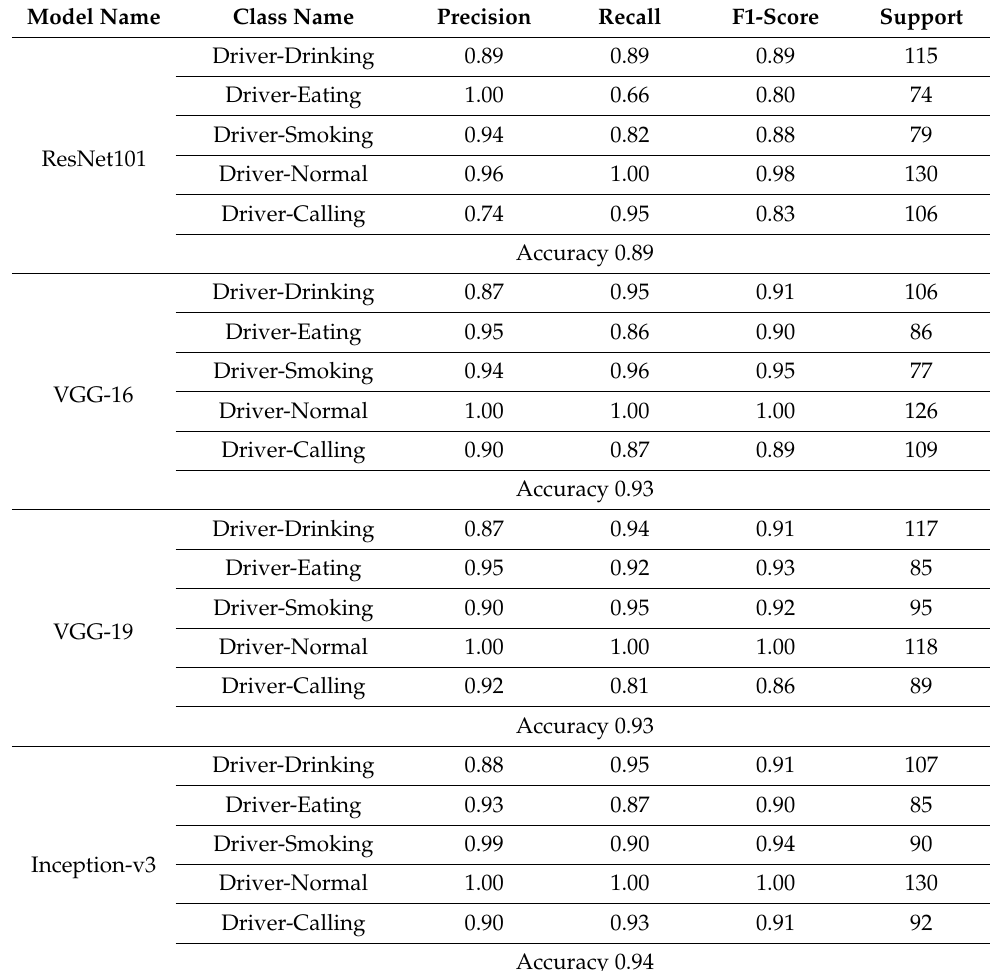
Table 3. Comparison value of Accuracy, Precision, Recall, and F1-measure for different